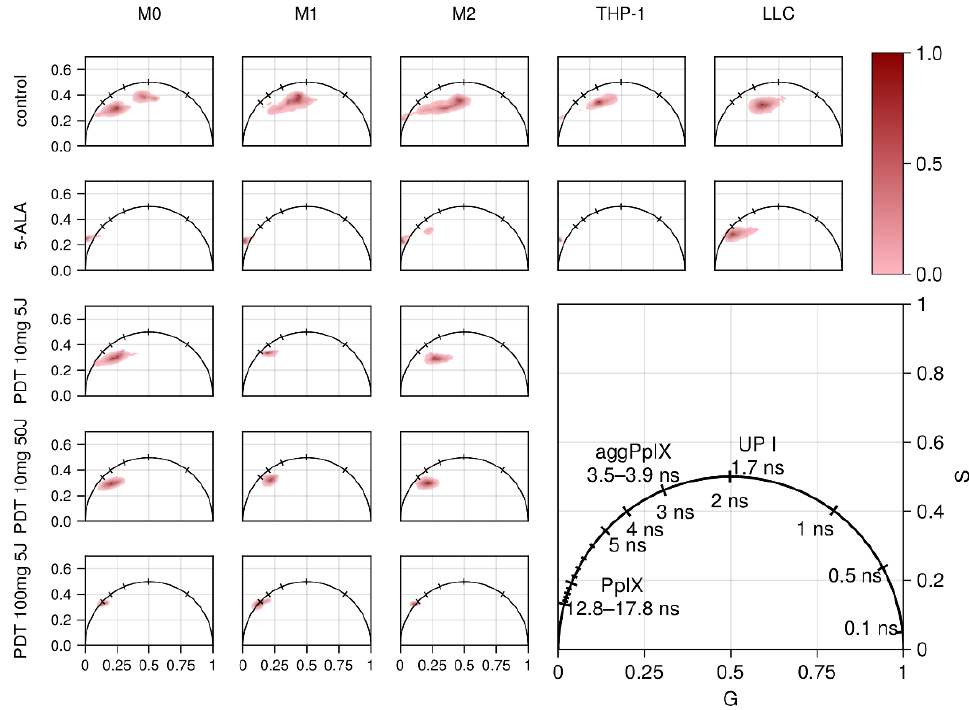
Figure 6. Phasor diagrams for time-resolved fluorescence images of cell culture PpIX fluorescence. Table 1. Specific fluorescence lifetimes for various cellular metabolites. Cellular Spectral Range Decay Time Components